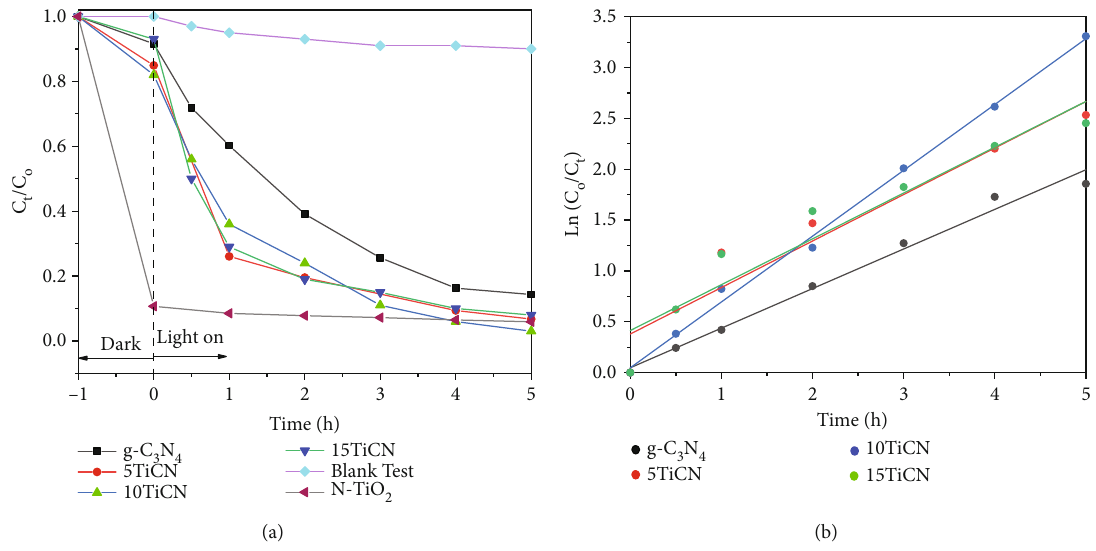
Figure 7: (a) Photodegradation e ffi ciency of OTC on x TiCN composites versus irradiation time and (b) kinetic of OTC degradation reaction on x TiCN